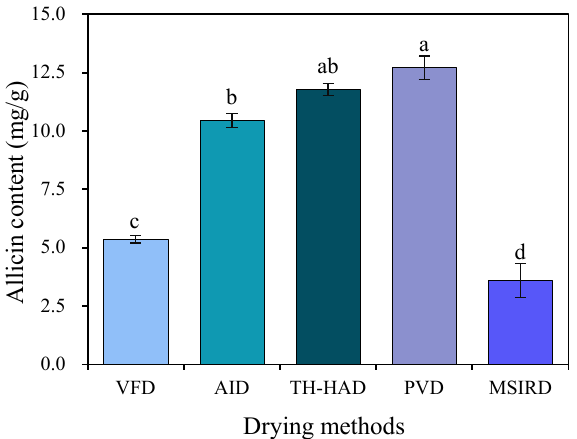
Figure 8. The allicin content of garlic slices dried in different methods. The different letter (a–d) indicates statistically significant difference at p < 0.05.